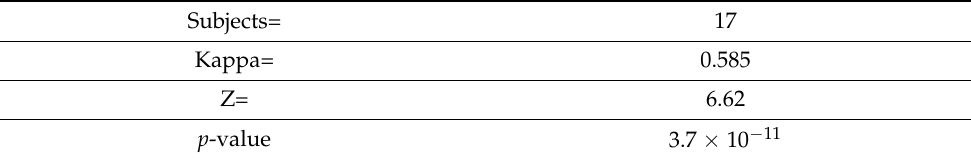
Table 2. Cohen’s Kappa for inter-rater reliability.